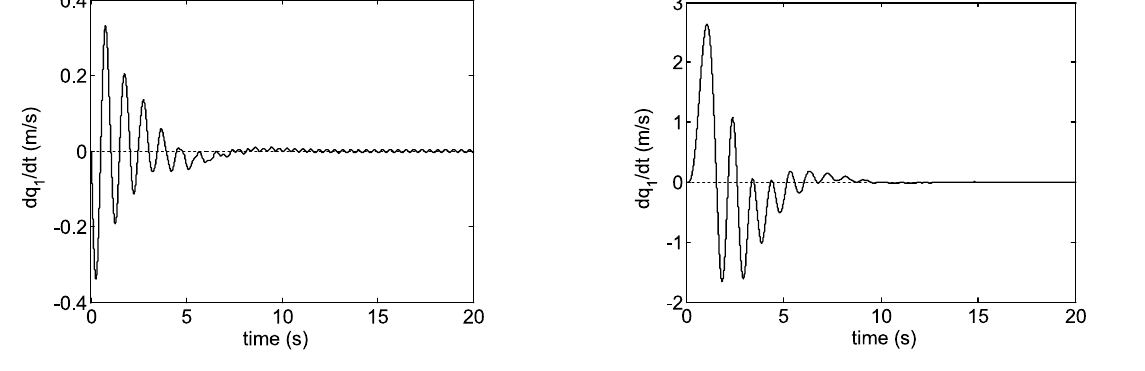
Fig. 13. Estimated behavior of variable ˙ q 1 considering same initial conditions for the angular displacements.